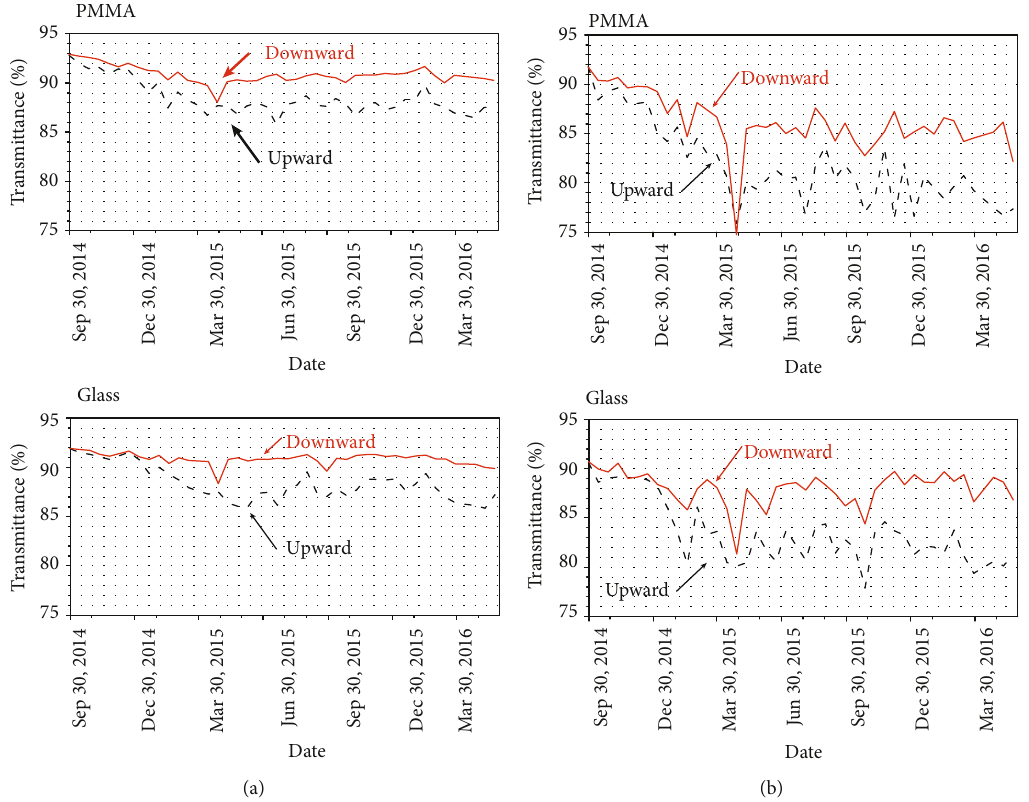
Figure 3: Changes in transmittance of the PMMA and glass substrates on the downward and upward systems during exposure at a wavelength of 500 nm measured (a) with and (b) without an integrating sphere.